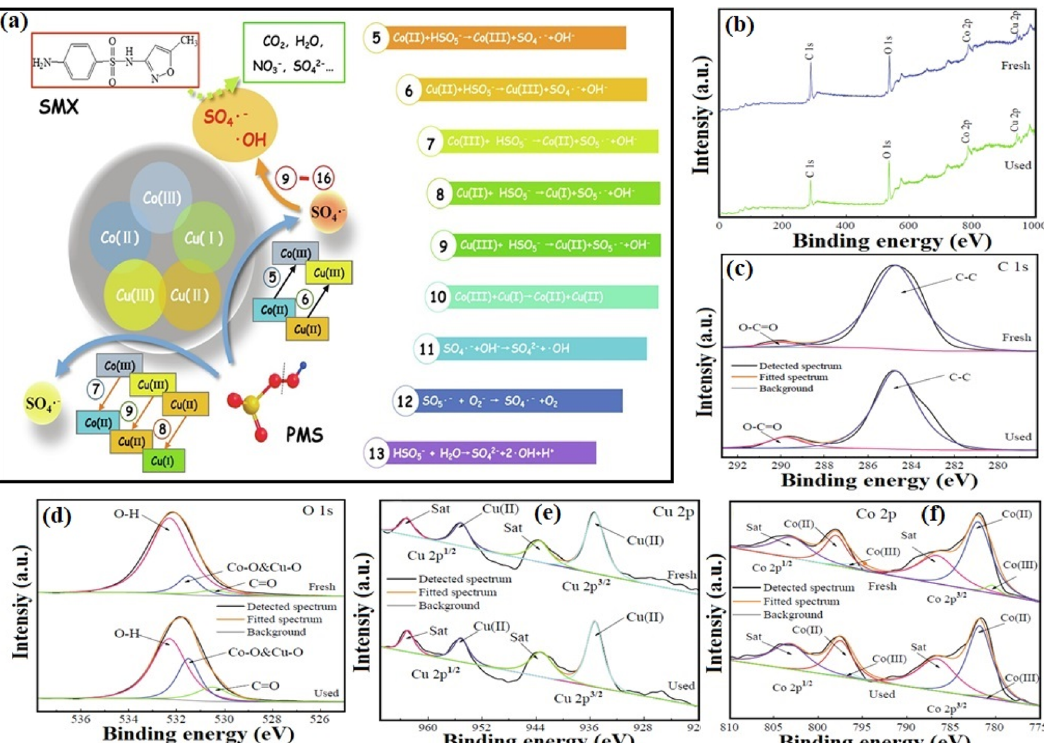
Fig. 6 The proposed degradation mechanism of SMX based on XPS spectra. a The PMS activation b XPS survey, c C1s, d O1s e Cu2p and f Co2p, adapted with permission from ref. 144 , Copyright, 2022,